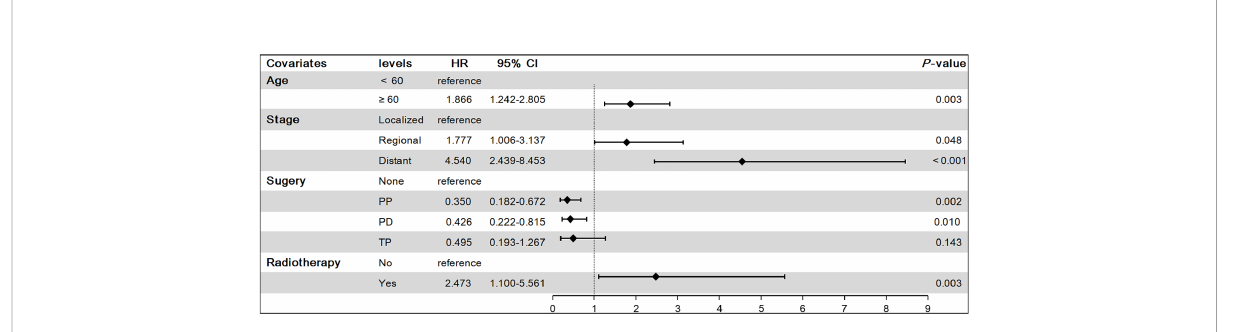
FIGURE 3 Results of multivariate Cox proportional hazards model on overall survival(OS). PP, Partial pancreatectomy; PD, Pancreatectomy and duodenectomy; TP, Total